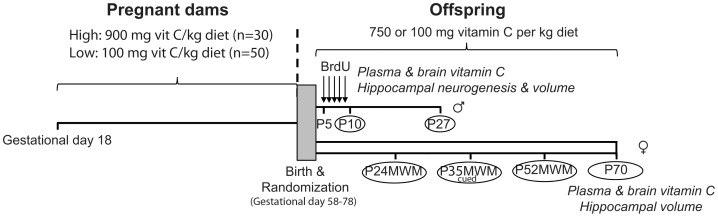
Overview of In Vivo Study.Eighty pregnant guinea pigs were weight-stratified into two groups at gestational day 18. Group High (n = 30) was assigned to a diet containing 900 mg of vitamin C per kg diet and group Low (n = 50) received a diet containing 100 mg of vitamin C per kg. Otherwise, diets were identical. Newborn pups were assigned to either of four dietary groups (CTRL, DEF, DEPL or REPL) by weight stratification. Weaned male pups (n = 83) received a daily BrdU injection (100 mg/kg body weight) between post-natal day (P) 5 and P9 and were sacrificed either at P10 or P27. Female animals (n = 77) did not receive BrdU. A subset (n = 36) were submitted to two consecutive tests in the non-cued Morris water maze (MWM) initiated at P24 and P52. A cued test (c-MWM) was performed on age-matched pups from both CTRL and DEF groups (n = 5 and n = 6, respectively) at P35. All female pups were sacrificed at approximately two months of age (P70). Biochemical and histochemical analyses were performed as indicated on the scheme.